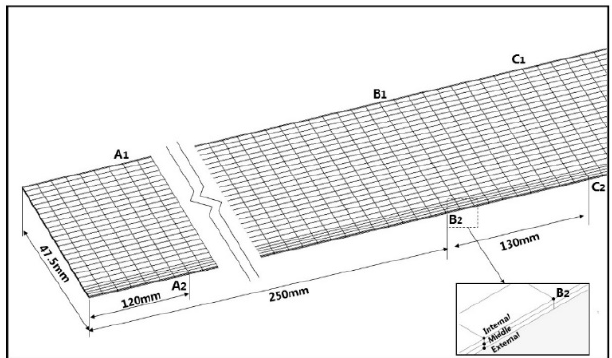
Figure 5. Node positions of the sheet metal model.